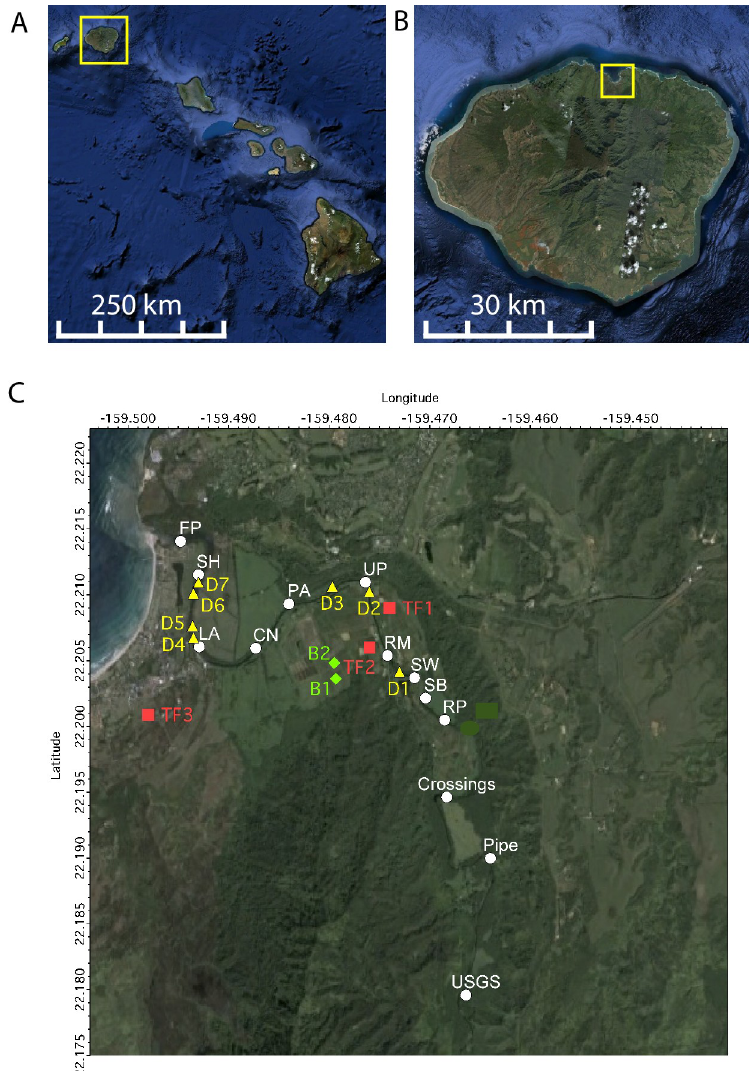
Fig 1. Map of study site. A. Hawaiian Archipelago, with the island of Kaua‘i boxed in yellow. B. Island of Kaua‘i. The yellow rectangle indicates the study area. C. Study area. White circles denote river cruise sites, yellow triangles denote locations of ditch samples, red boxes denote taro lo’i field (TF) samples, and green diamonds represent bird refuge pond (B) samples.